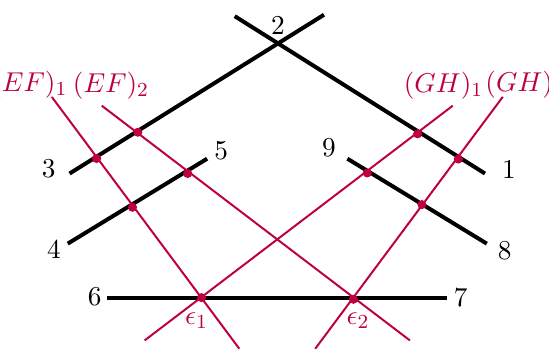
Figure 4 . Two pairs of solutions for ( EF ) and ( GH ) from the leading singularity of double-box integral; ( EF ) intersects with (23) , (45) , (67) and ( GH ) ; ( GH ) intersects with (12) , (89) , (67) and ( EF ) . Intersections of ( EF ) i with ( GH ) i both lie on the line (67) , which are call (cid:15) 1 and (cid:15) 2